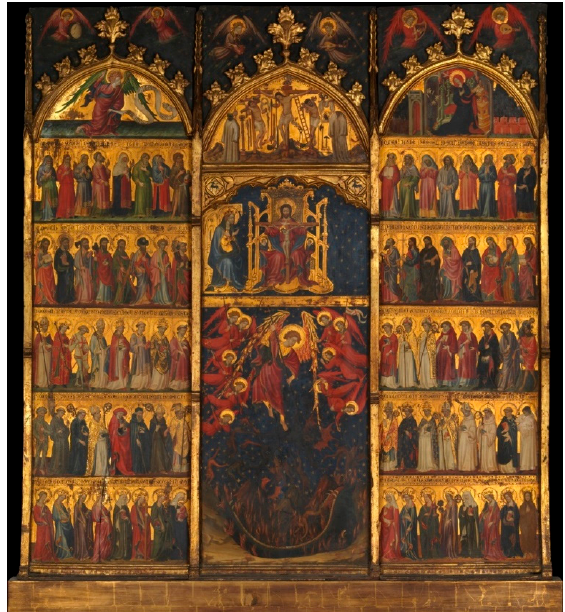
Figure 7. The Trinity adored by all saints. New York, Metropolitan Museum of Art. Used by permission.